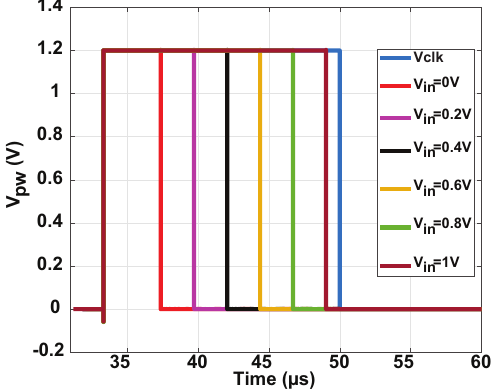
Figure 4. Pulse width signal V pw for different V in